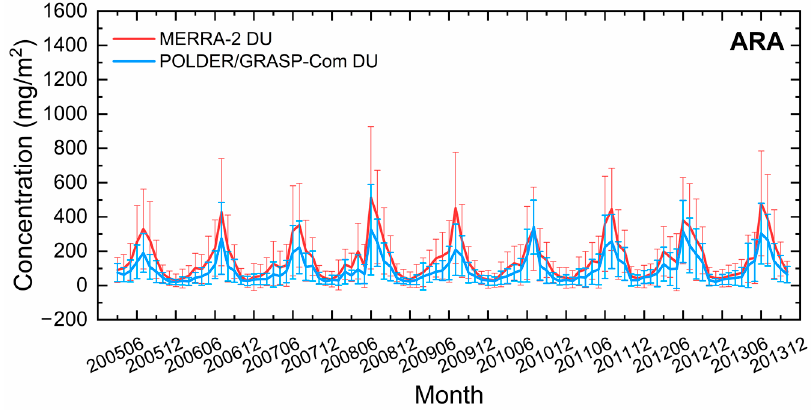
Figure 11. Same as Figure 3, but for Arabian Sea (ARA)